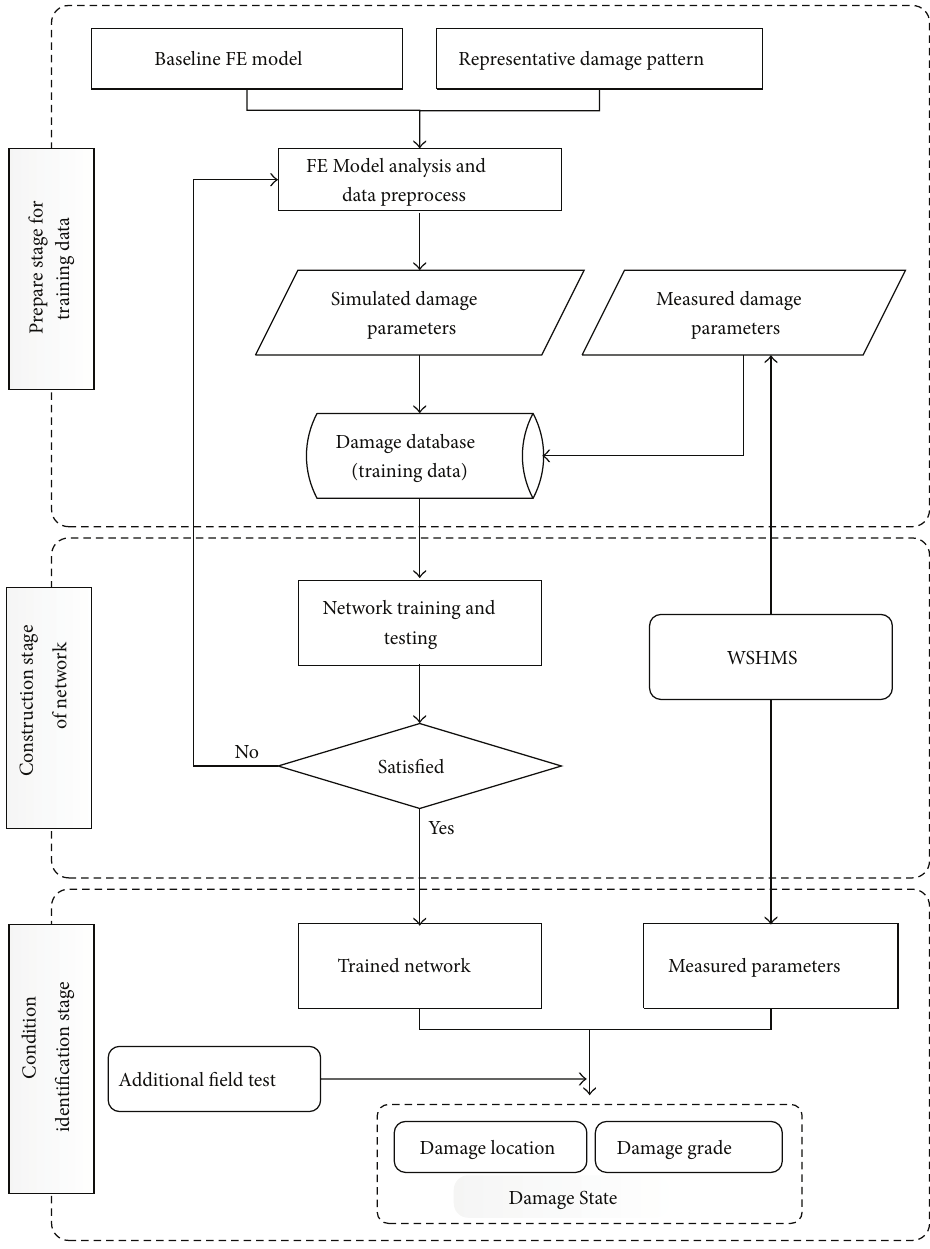
Figure 16: Further damage diagnosis based on neural